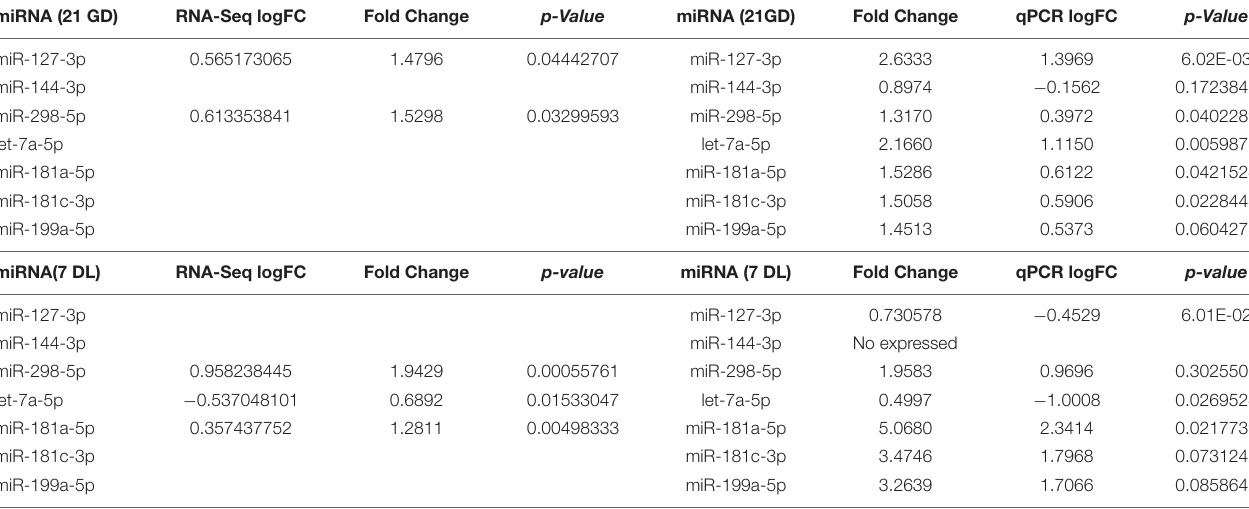
TABLE 5 | Comparison between the values obtained in the miRNA sequencing and the validation by RT-qPCR. miRNA (21 GD) RNA-Seq logFC Fold Change p-Value miRNA (21GD) Fold Change qPCR logFC